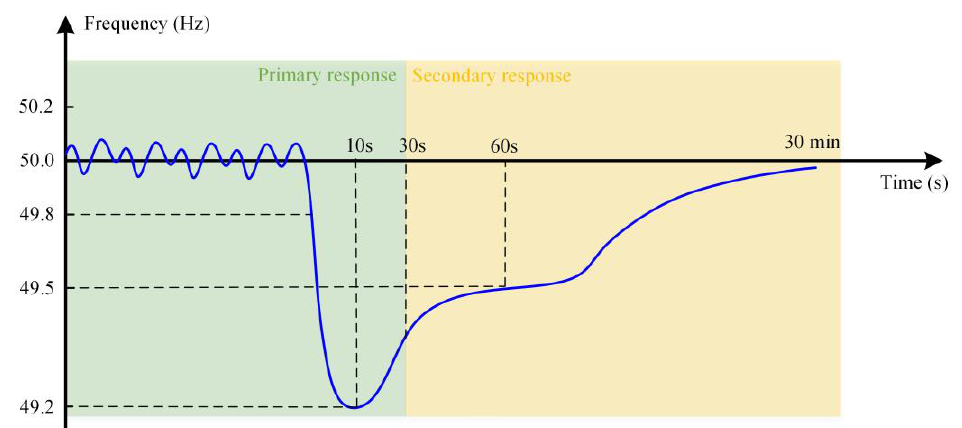
Figure 3. Time frames involved in the system frequency response [14].